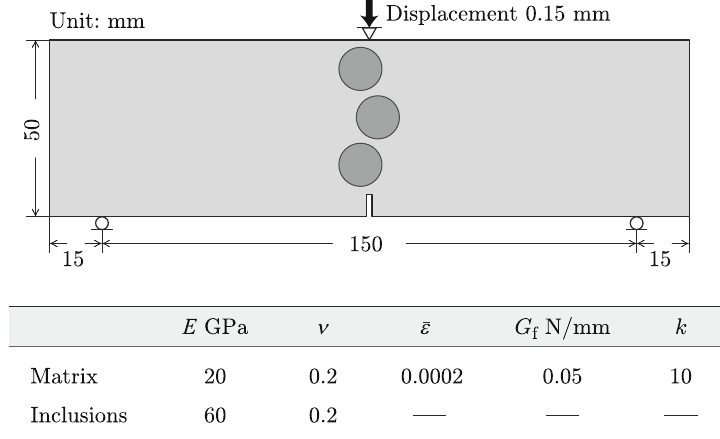
Fig. 7 Three-point bending problem of beam with three circular inclusions